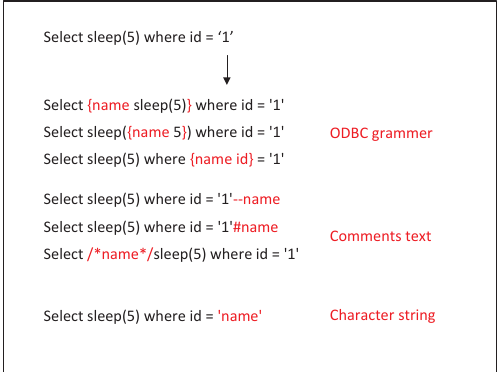
Figure 7. The points of insertion in normal